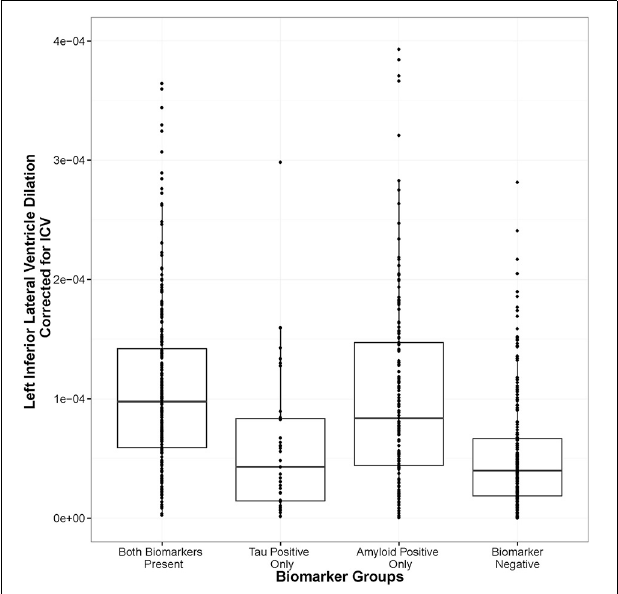
FIGURE 1 | Amyloid positivity and combined biomarker positivity predict ventricular dilation. Biomarker groups are along the x-axis and annual change in left inferior lateral ventricle volume is on the y axis. The groups differ in their mean annual change, [ F (3 , 679) = 6 . 50, p = 0 . 0002], with the amyloid positivity alone ( t = 4 . 144, p = 0 . 00003) and the combined amyloid/tau positivity ( t = 2 . 83, p = 0 . 005) groups showing significant deviation from the biomarker negative referent